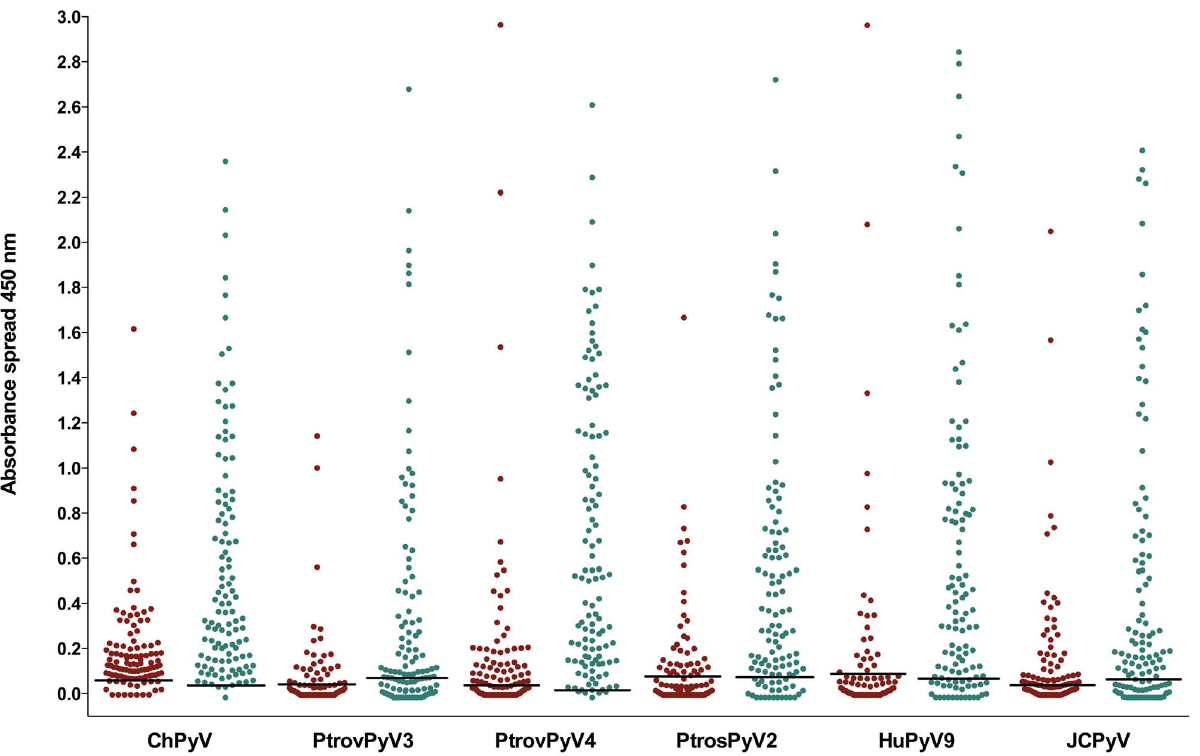
Figure 3. Reactivity of human sera to VP1 proteins of chimpanzee and human polyomaviruses. Antibody reactivity was assessed against 4 chimpanzee polyomaviruses (ChPyV, PtrovPyV3, PtrovPyV4 and PtrosPyV2) and 2 human polyomaviruses (HPyV9 and JCPyV) using sera from German (n=111) and of plasma samples from Ivorian subjects (n=115). Samples were analysed for seroreactivity with a capsomer-based IgG ELISA using the VP1 major capsid protein of the above polyomaviruses as antigens. The spread of absorbance measurement is shown with green and red dots (representing the German and Ivorian panels, respectively). COVs are shown as solid lines within the graph (COVs of Germans/Ivorians: ChPyV: 0.057/0.034; PtrovPyV3: 0.046/0.070; PtrovPyV4: 0.038/0.012; PtrosPyV2: 0.081/0.080; HPyV9: 0.089/0.066; JCPyV: 0.047/0.079).